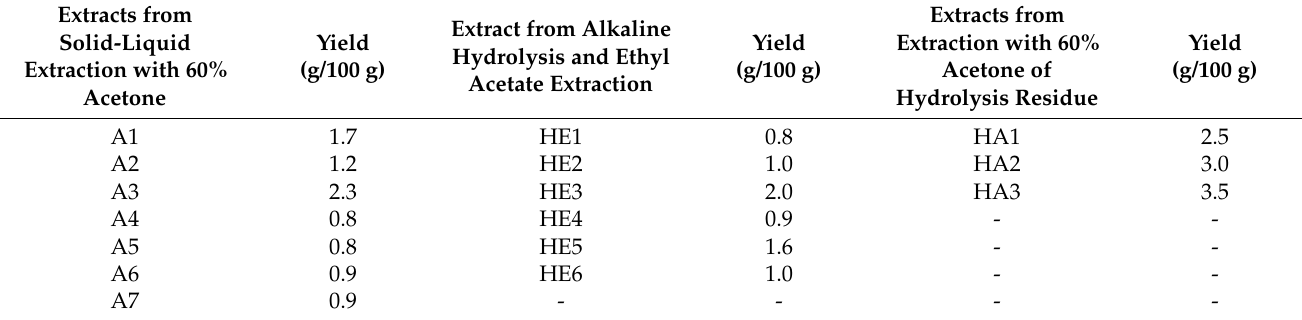
Table 4. Extraction yields of BSG extracts prepared by SPE purification and lyophilization. Extracts from Solid-Liquid Extraction with